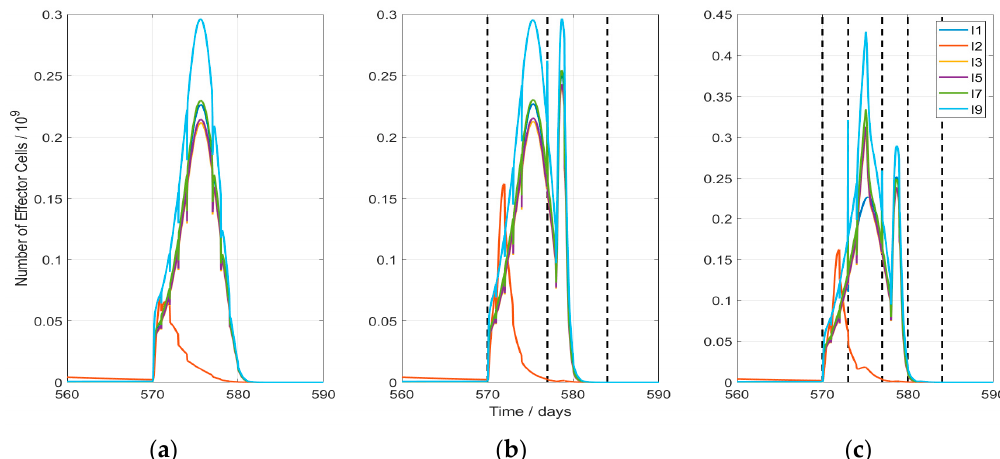
Figure 5. Development of effector immune cells during RT and HT-RT (in case of HT-induced modification of all parameters, according last column in Table 4). The impact of every RT fraction (5 fractions in the first week starting at day 570 and 4 of 5 fractions of the 2nd week starting at day 577) on the effector cells is visible as a spike-shaped drop of the cell number. The scenarios presented here correspond to ( a ) Case with no HT (RT1HT0); ( b ) Case RT1HT3; ( c ) Case RT1HT2. A dashed line is plotted each time a HT session is performed.